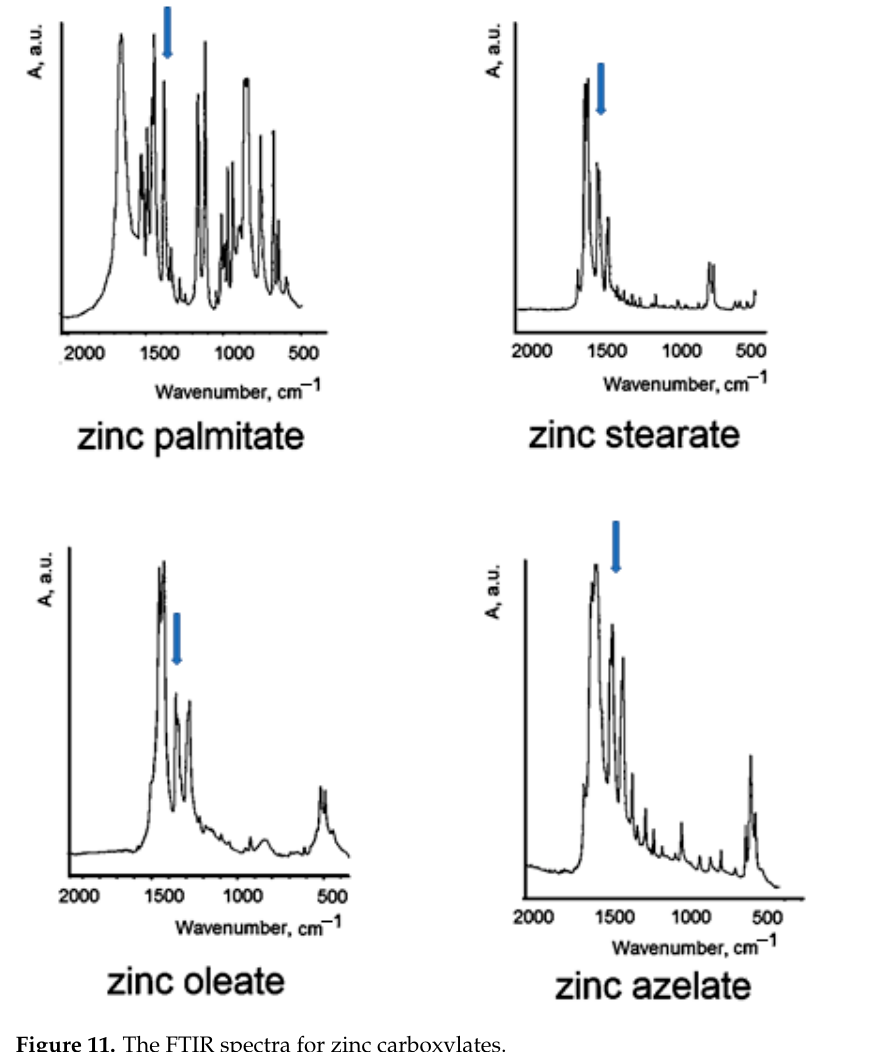
Figure 11. The FTIR spectra for zinc carboxylates.